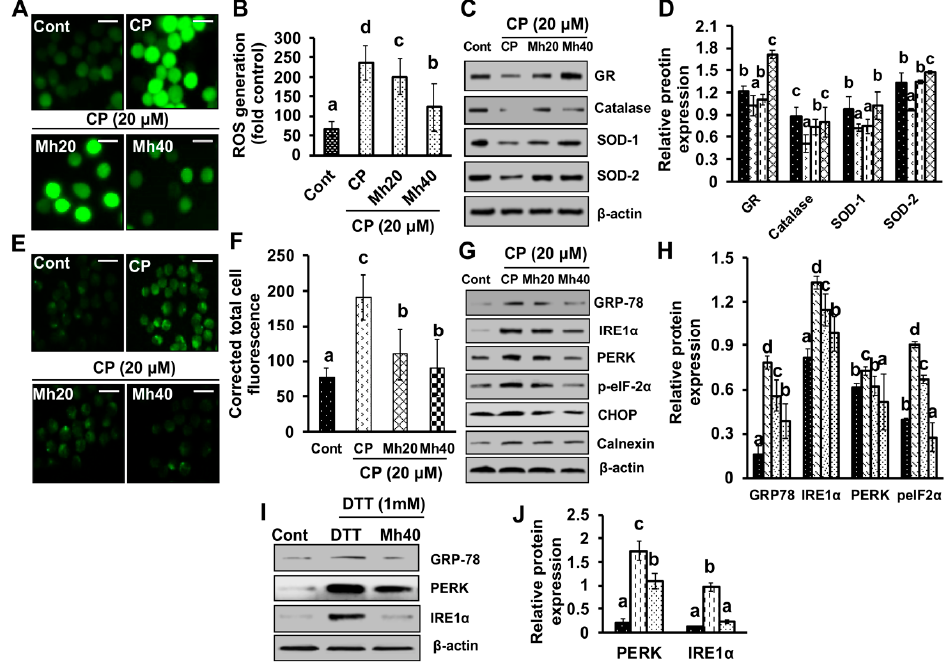
Figure 2. Effect of CP and CP-Mh on cellular oxidative stress. ( A ) Cellular reactive oxygen species (ROS) levels in HepG2 cells after corresponding drug treatment were visualized by fluorescence microscopy (scale bar 0.1 mm). ( B ) Corresponding ROS fluorescence intensity was measured manually by Image J software. ( C ) Western blot analysis of oxidative stress-related markers was done using specific antibodies for GR, catalase, SOD-1 and SOD-2, with β -actin used as an internal loading control. ( D ) Relative expression of GR, catalase, SOD-1 and SOD-2, was analyzed by densitometry analysis by ImageJ software. ( E ) HepG2 cells were stained with Fura-2AM after relevant drug treatment and assayed under a fluorescence microscope (magnification 400 × , scale 0.1 mm). ( F )